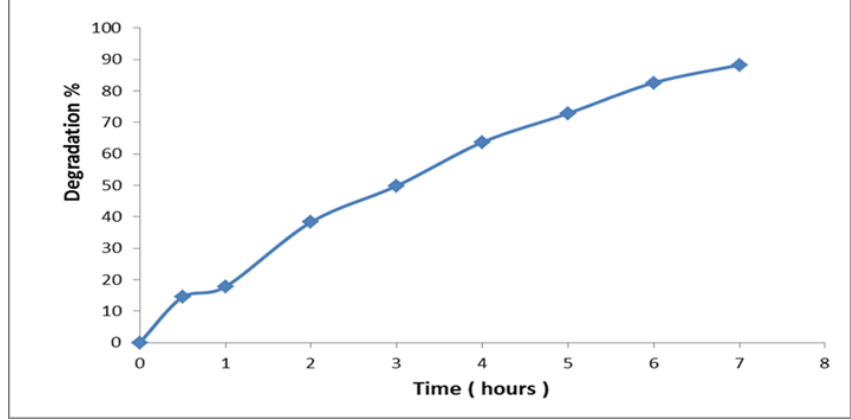
Fig.8: Degradation percentage versus time of